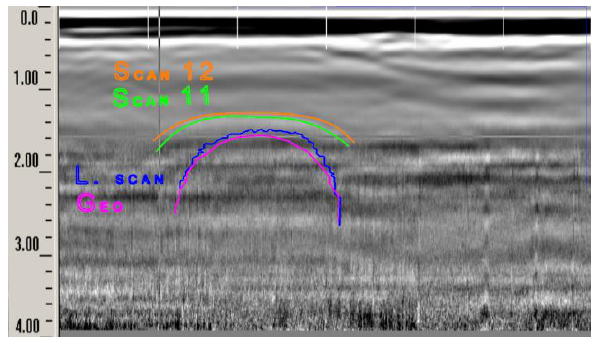
Figure 6. Ground penetrating data with sections threw models created from laser scanning data and geodetic measurement.